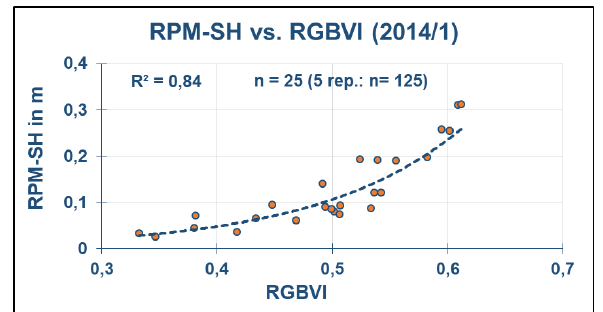
Figure 4. Relationship of RPM-SH and RGBVI data A similar relationship is given when plotting RPM-SH against UAV-derived CSM-SH data. CSM-SH was UAV-derived according to the CSM approach by Bendig et al. (2013) and is performing well against the manual RPM-SH measurements. The R 2 results in 0.82.